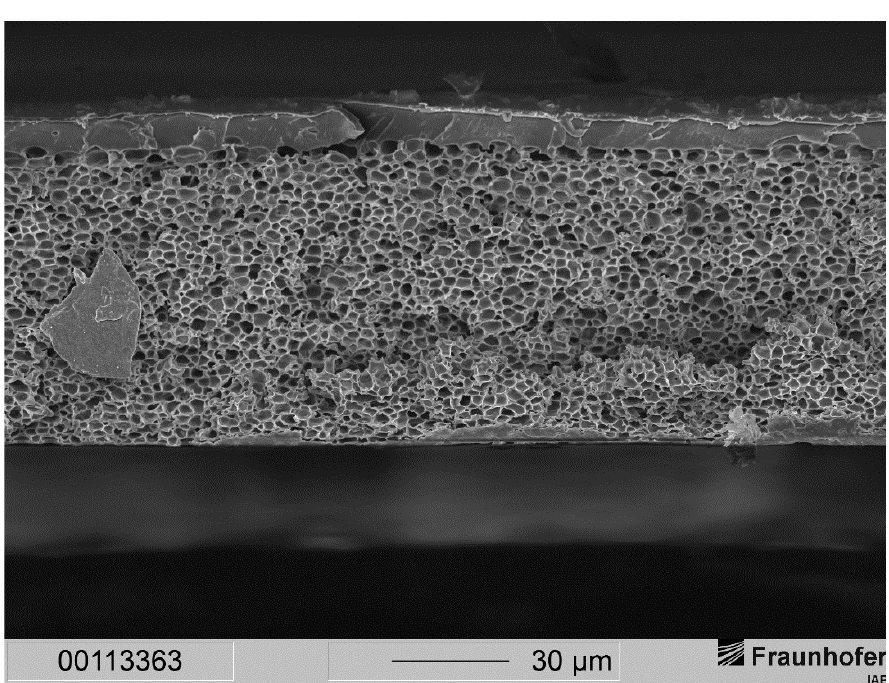
Figure 4. Cross-section of a layered PSU flat sheet membrane fabricated after conditions shown in Table 1. Table